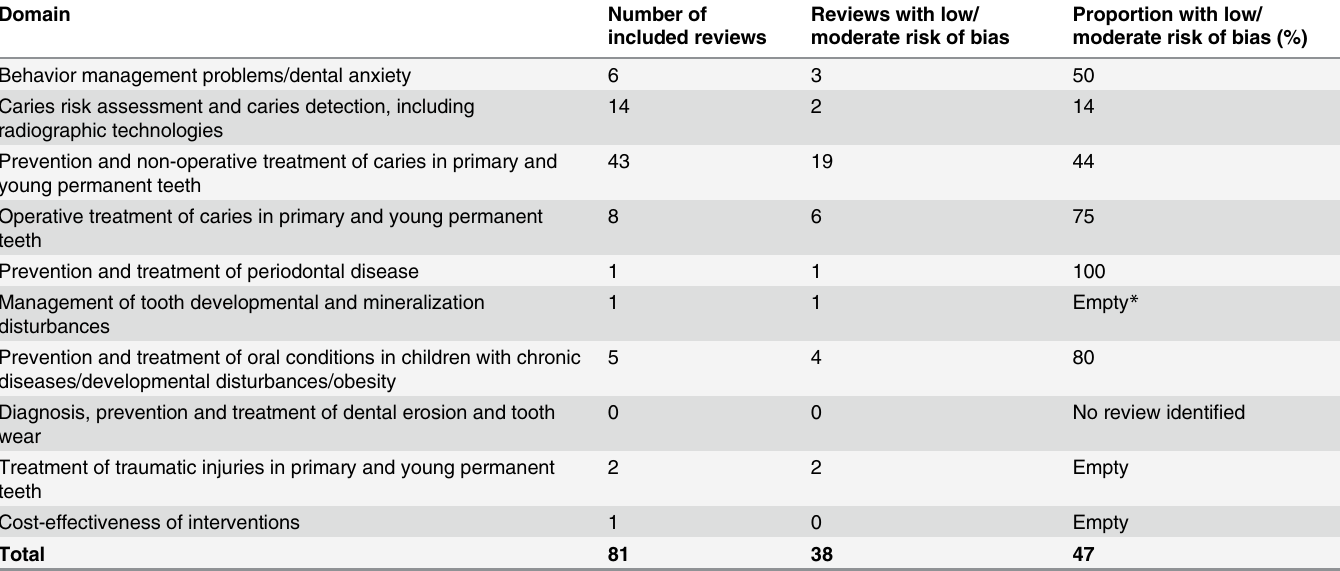
Table 2. Number and distribution of included systematic reviews and number and proportion of reviews with low/moderate risk of bias according to the ten selected domains in pediatric dentistry.